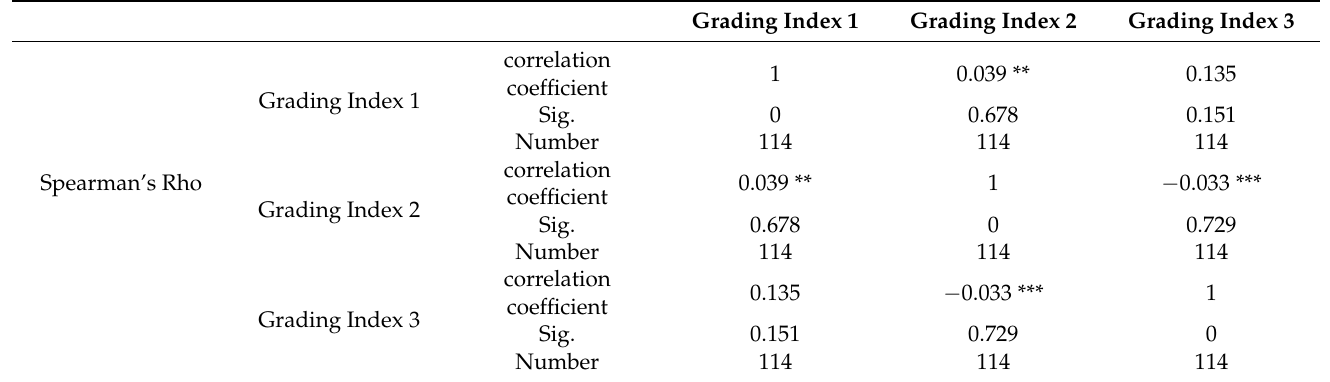
Table 6. Analysis results of Spearman’s index for grading indicators.